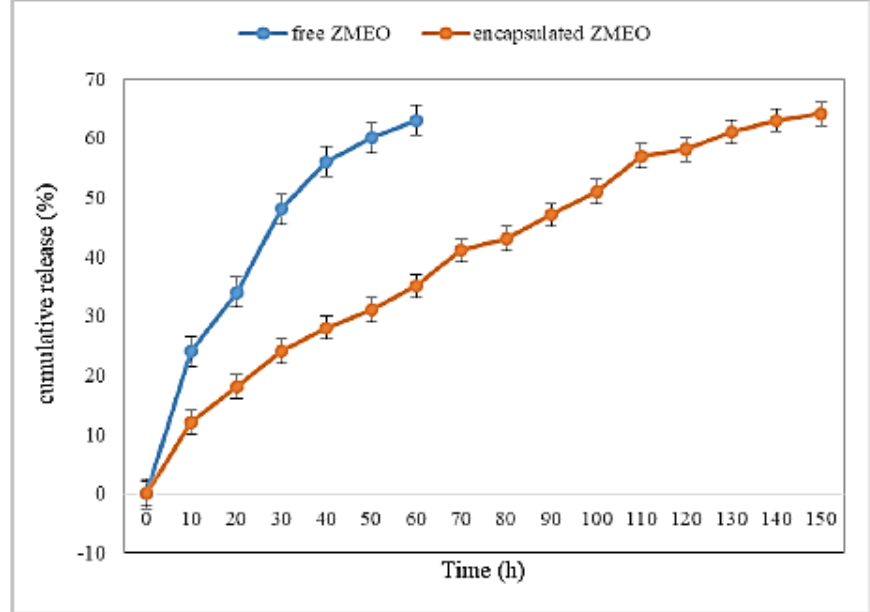
Figure 4. Release profile of ZMEO free and encapsulated into PVA fiber film.